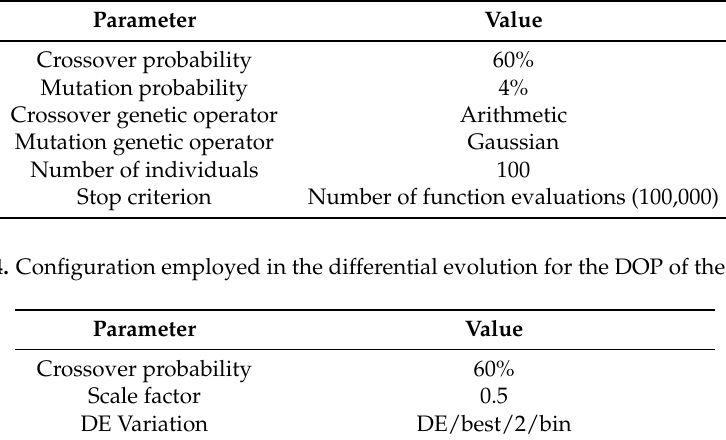
Table 3. Configuration employed in the genetic algorithm for the DOP of the DRTO.